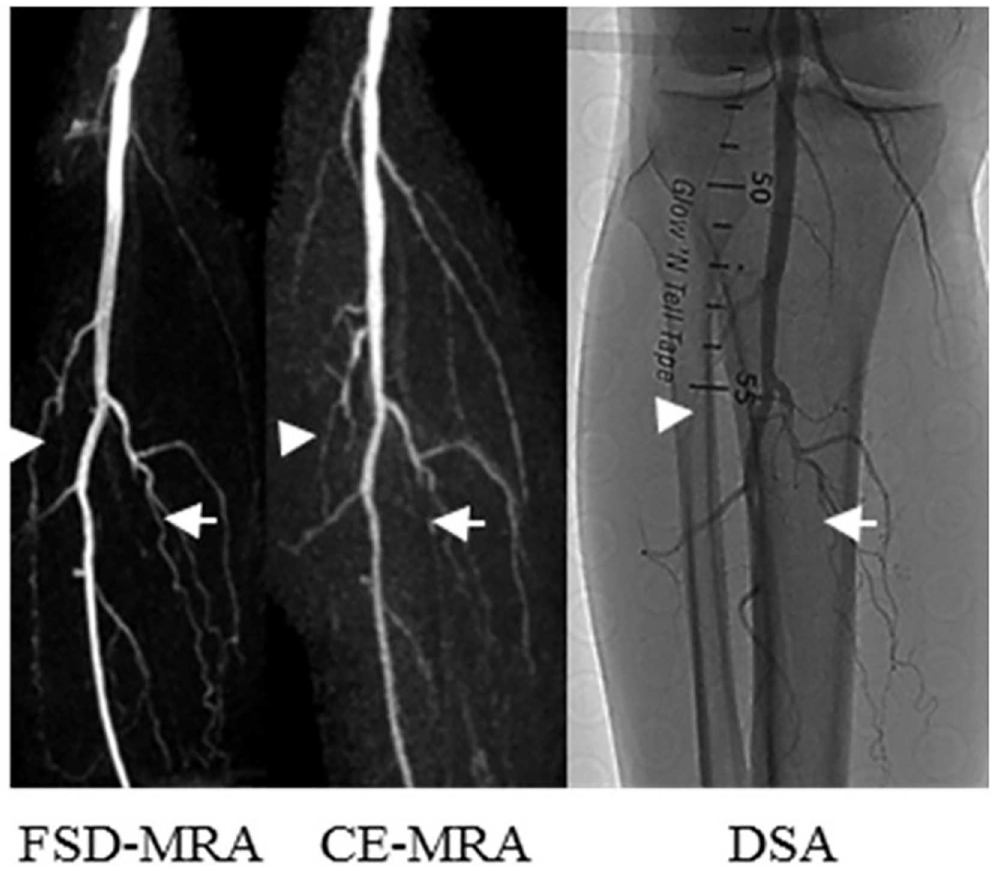
Fig 1. Images from a 64-year-old male patient who suffered from intermittent claudication for 8 yearsand rest pain for 1 month. Consistent with CE-MRA and DSA, FSD-MRA revealed an occlusivelesion on the right anterior tibial artery (white arrow) and right posterior tibial artery (white arrowheads) with collateralartery